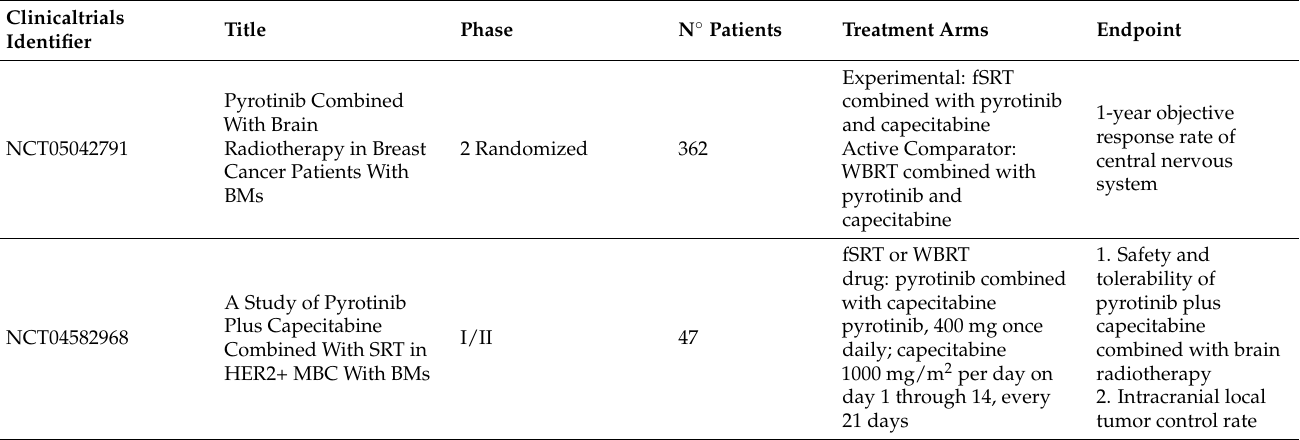
Table 4. Ongoing clinical trials of combinations of brain RT with systemic therapy in the treatment of